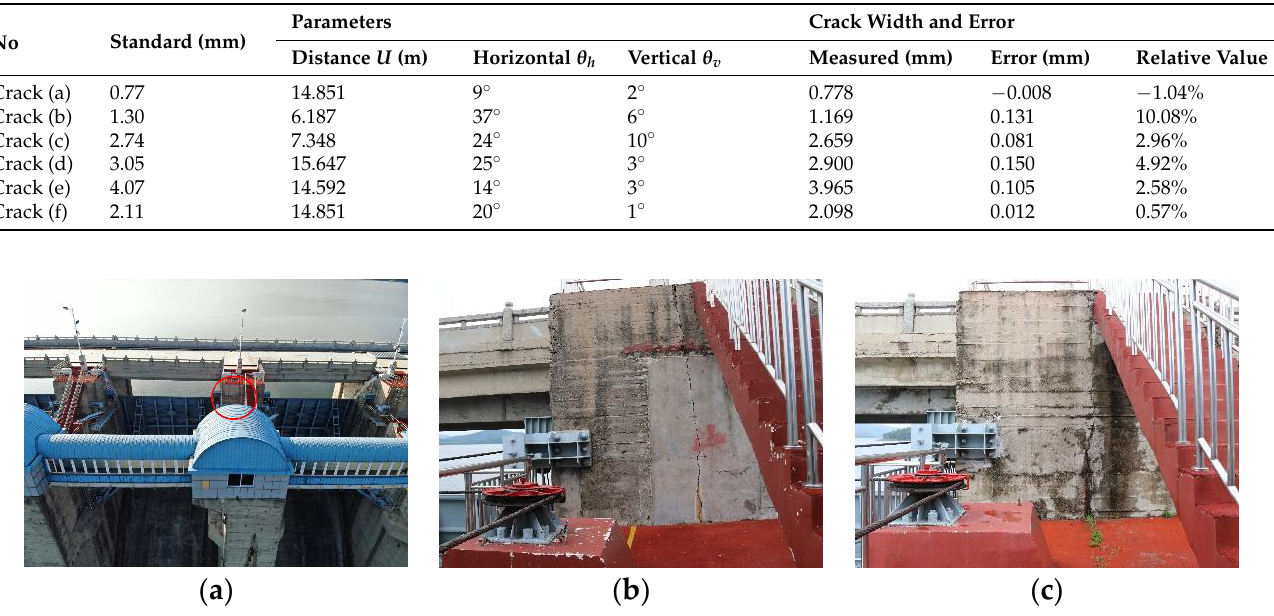
Figure 25. Cracks on concrete dam pier with different background and segmentation results. ( a ) narrow crack, ( b ) artificial mark interference, (c) boundaries refinement, ( d ) blurry boundaries, ( e ) accurate segmentation, ( f ) artificial mark interference, ( g ) blurry boundaries, ( h ) boundaries refine- ment